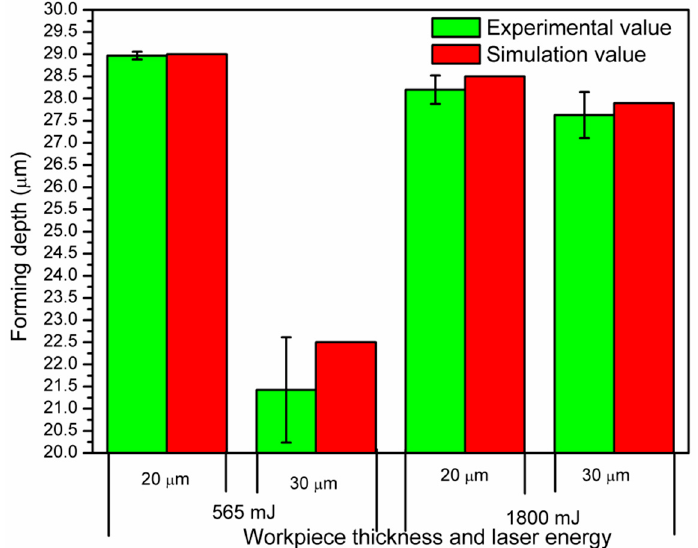
Figure 19. The forming depth of the embossed microchannel in the experiments and numerical simulation.